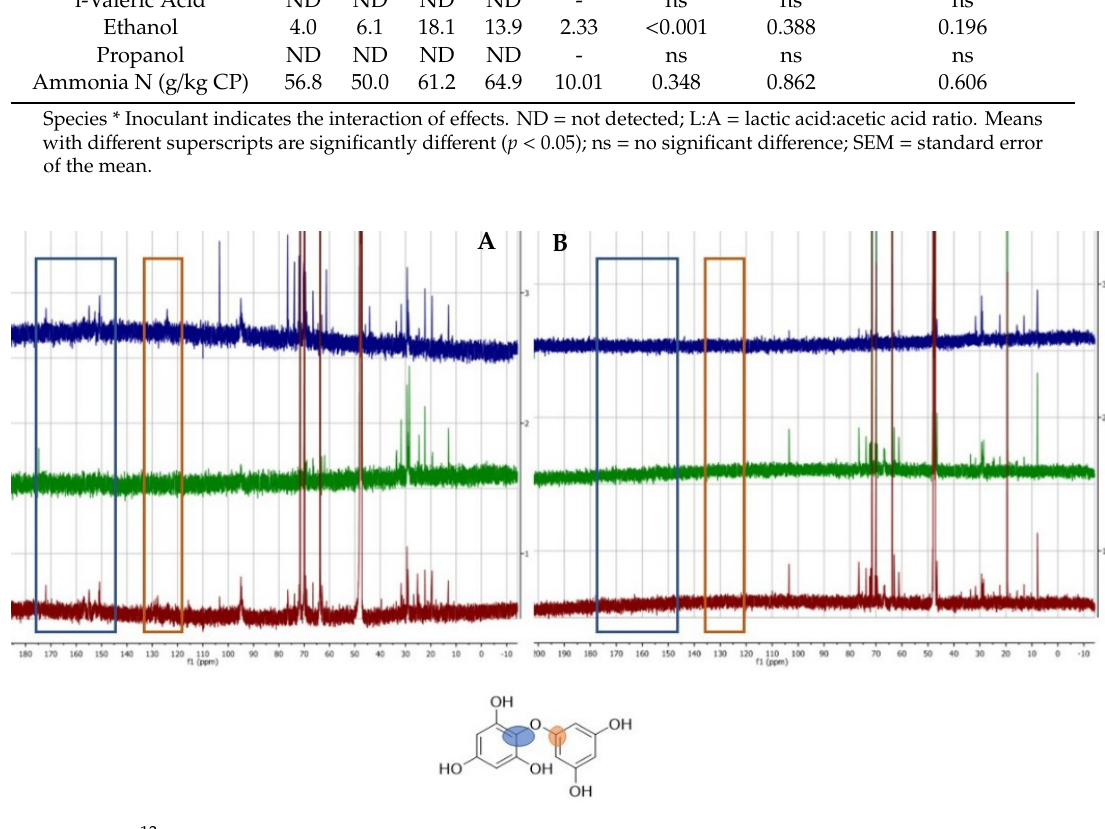
Figure 4. 13 C-NMR seaweed spectra of FV ( A ) and SL ( B ). The coloured spectra show the seaweeds before (FV0, SL0: blue) and after ensiling, with (FVi, SLi: green) and without (FVu, SLu: red) the inoculant. The blue and orange boxes represent the C-O-C bonds that are shown on the chemical structure below.